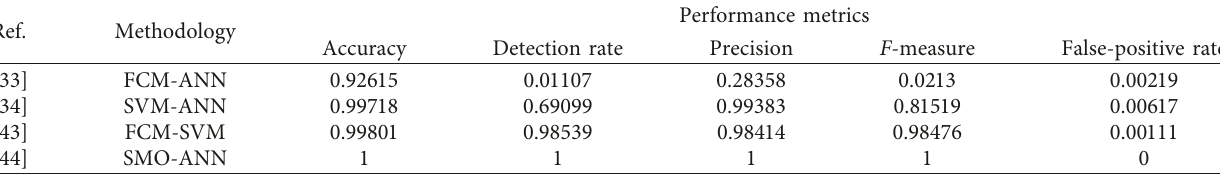
Table 11: Comparison of various methodologies based on different performance metrics for shellcode attack. Ref.